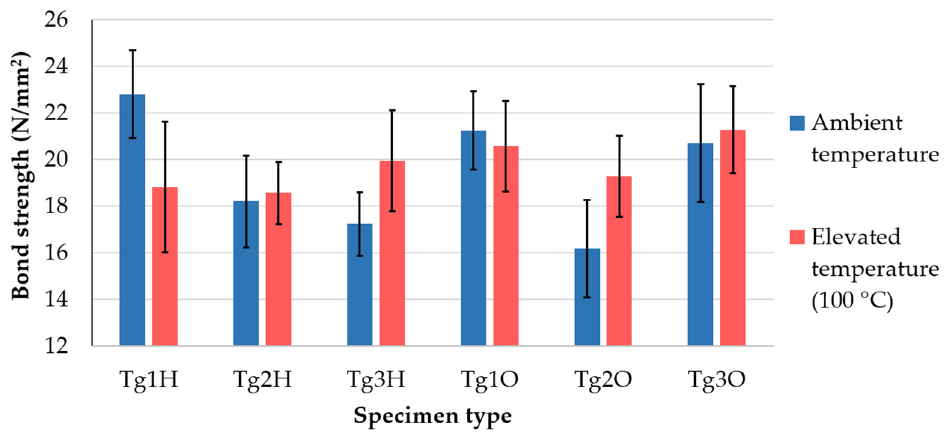
Figure 11. Comparison of the results according to the testing temperature.